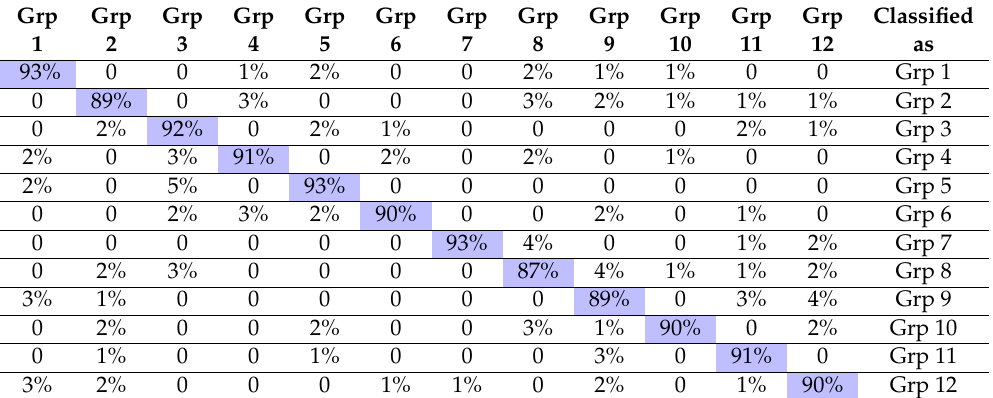
Confusion matrix of n -fold cross-validation (10-fold) results for Urdu handwritten characters classification.